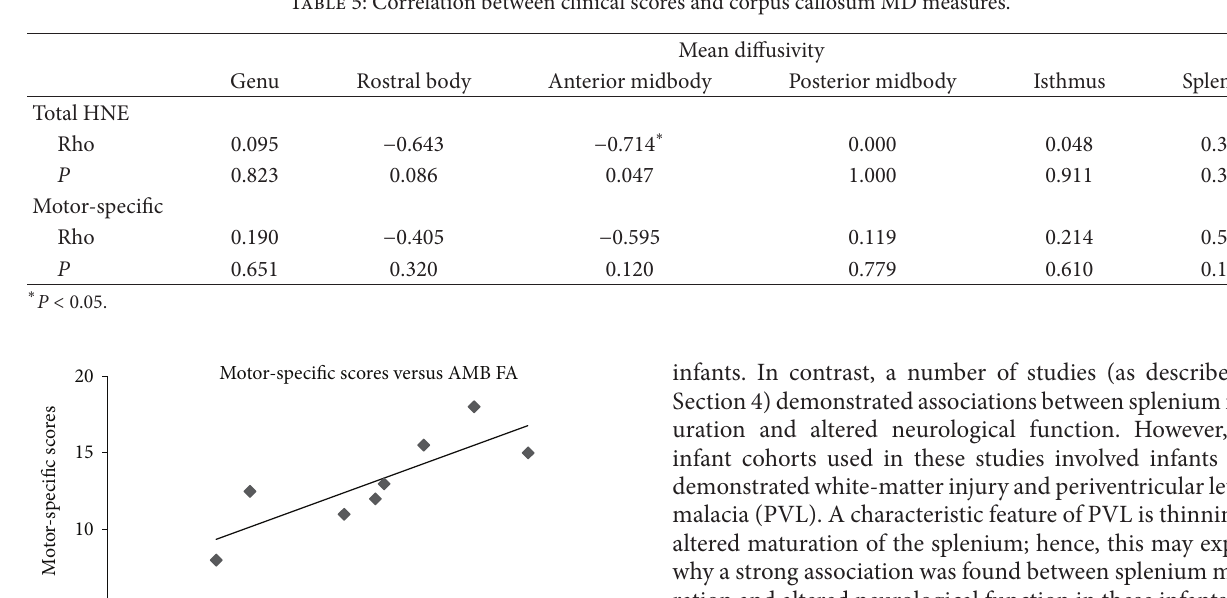
T 5: Correlation between clinical scores and corpus callosum MD measures.